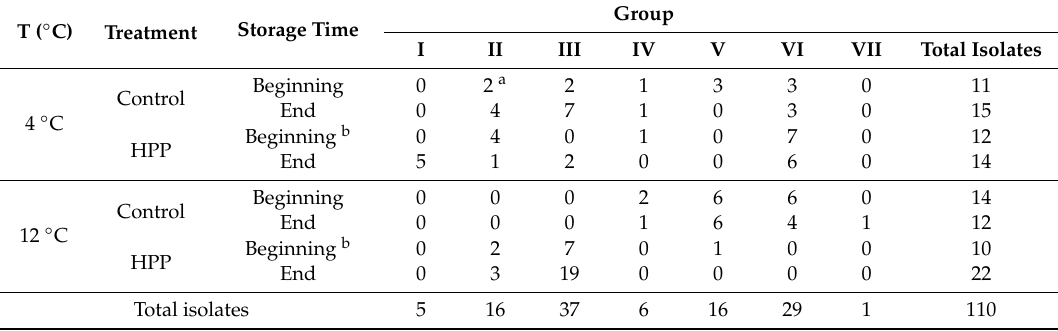
Table 1. Distribution of B. thermosphacta isolates at the beginning and the end of storage under vacuum package of chicken fillets at 4 ◦ C and 12 ◦ C untreated (control) or treated with HPP (500 MPa / 10